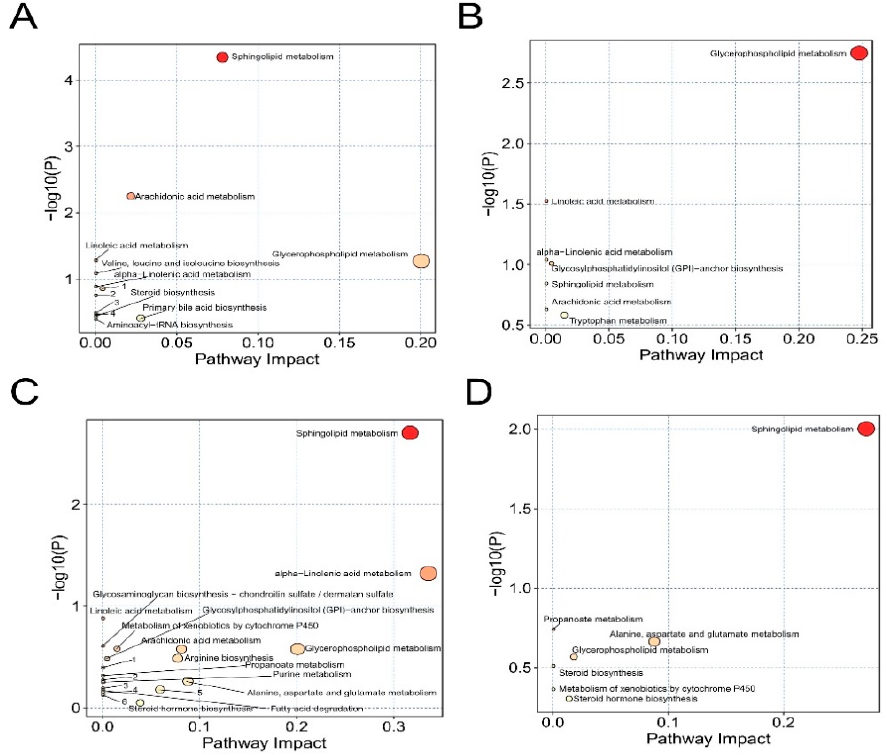
Figure 6. Summary of KEGG pathway analysis with MetaboAnalyst. ( A ) plasma_tMCAO/Sham,